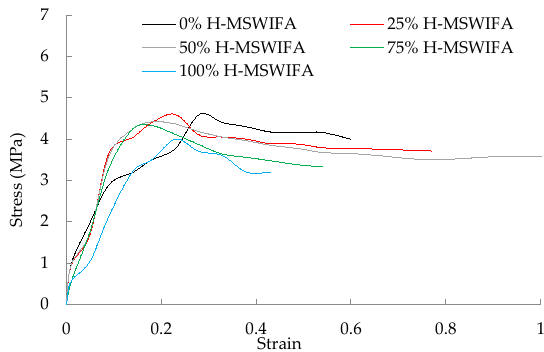
Figure 10. FSFE curve of asphalt mastic at F/A of 1.2.